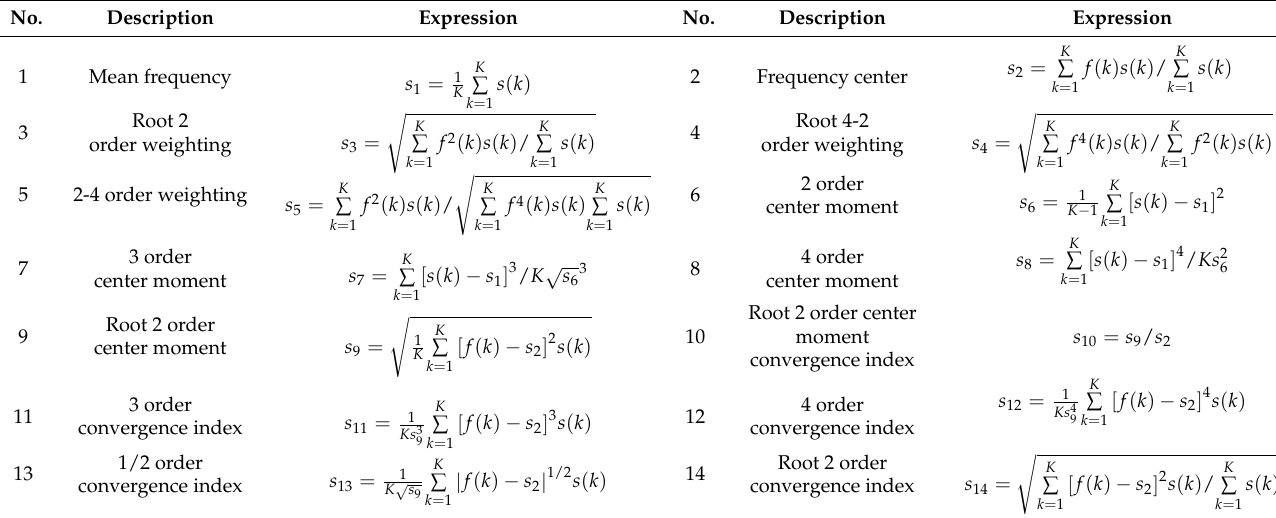
Table 3. Statistical features in the